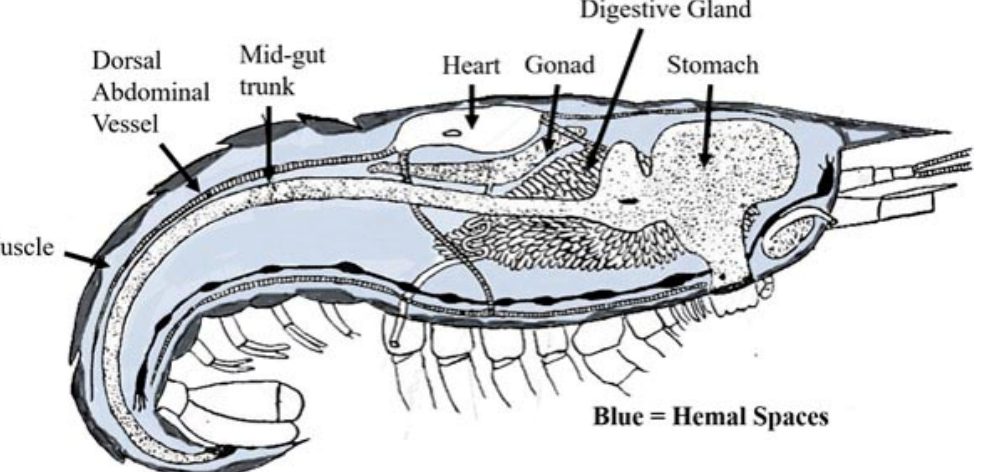
Figure 1. Schematic of shrimp anatomy displaying organs adjacent to hemal spaces. Blood also fills the heart and dorsal abdominal artery and surrounds individual tubules within the digestive gland.